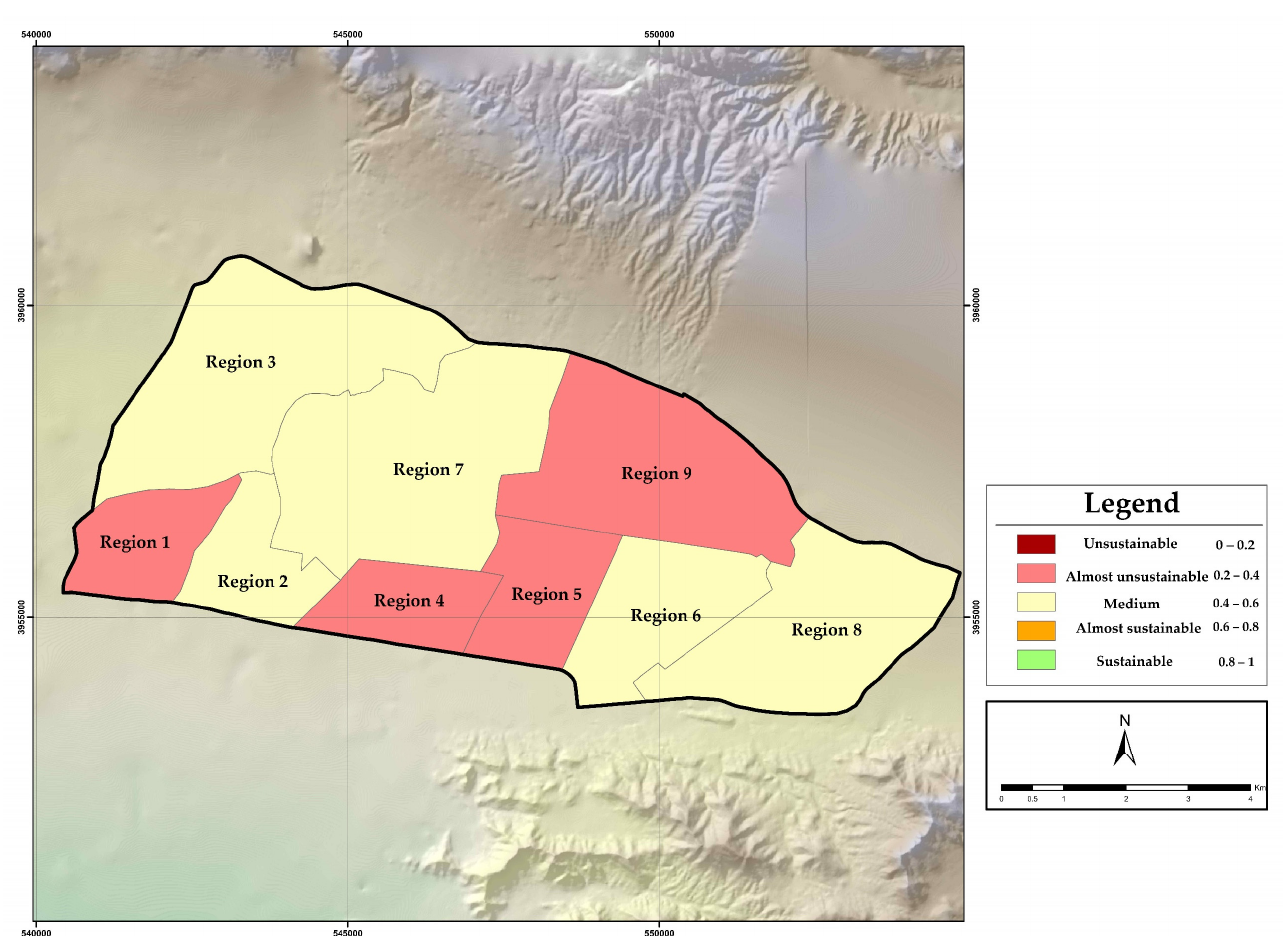
Figure 13. Sustainability map of 9 regions of District 4.